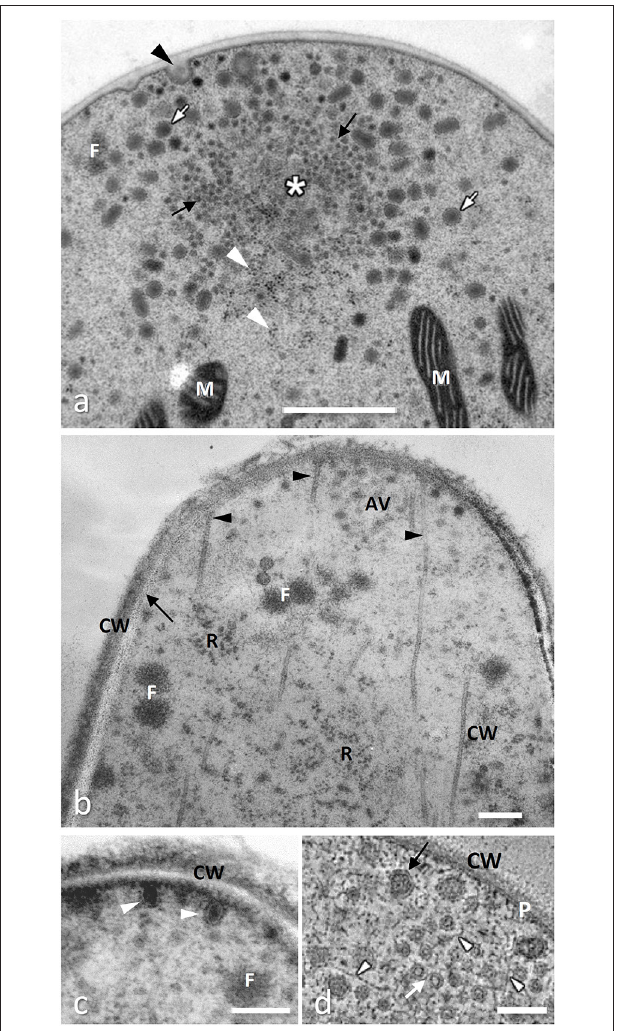
FIGURE 1 | Extreme hyphal tips cryofixed and freeze substituted. (a) Neurospora crassa (Ascomycota) showing a typical Spitzenkörper formed by a cluster of apical vesicles around a core mainly composed of actin filaments (asterisk); actin filaments are also present in smaller clusters (filasomes, F) usually close to cell membrane; vesicles are of different size and electron density, the smallest (microvesicles, black arrows) are apparently surrounded by larger ones (macrovesicles, white arrows) and many ribosomes (white arrowheads); vesicles exocytosis is often visible (black arrowhead) while mitochondria (M) are rare in the extreme tip (from Roberson, 2020, with permission of the publisher). (b) Tuber melanosporum , Ascomycota, showing apical vesicles (AV) organized in a possibly simplified Spitzenkörper and microtubules (arrowheads) running to the plasma membrane which appears linear (arrow) between the cell wall (CW) and the cytoplasm, rich in ribosomes (R); (from Amicucci et al., 2011, with permission of the publisher). (c) An enlarged serial section of the same hyphal tip as in (b) showing chitosome-like vesicles (arrowheads) delivering they cargo of chitin synthase to the plasma membrane to build cell wall (CW) which appears not fully organized yet. (d) Aspergillus nidulans G.Wint, Ascomycota: TEM tomography of the hyphal tip: by this technique microvesicles (white arrows) and apical vesicles (black arrow) appear clearly embedded in a matrix of actin microfilaments (white arrowheads); the double layer of the plasma membrane (P) is also clearly visible; (from Hohmann-Marriott et al., 2006, with permission of the publisher). All bars, 0.2 µ